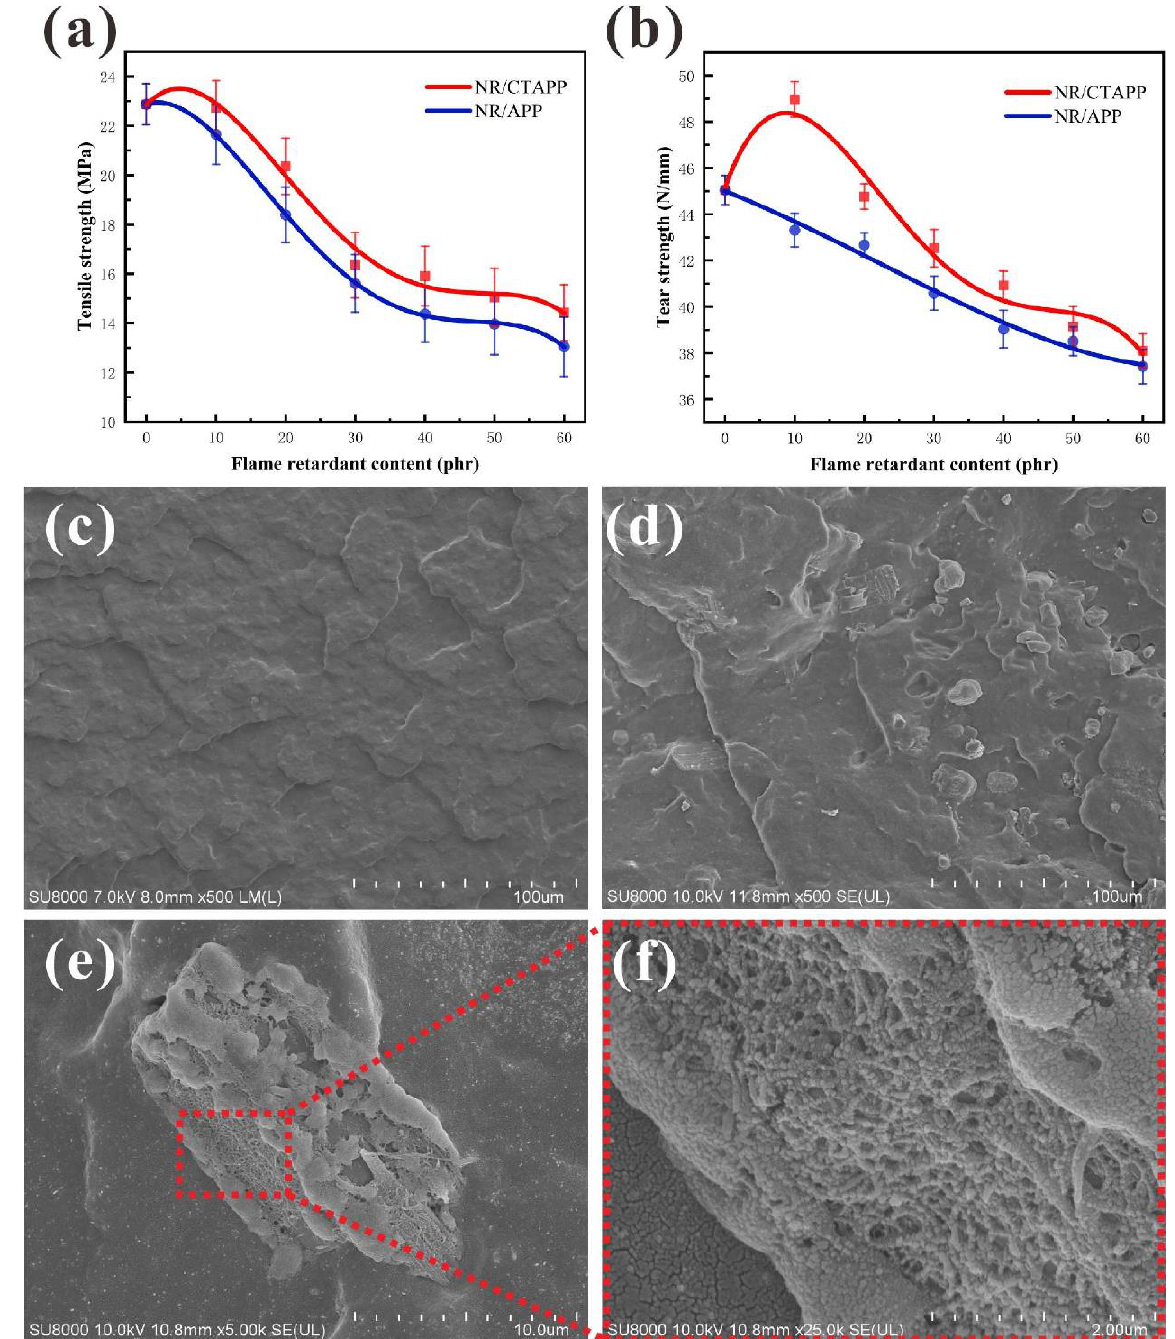
Figure 9. Mechanical properties analysis of composites: ( a ) tensile strength of NR/CTAPP and NR/APP composites; ( b ) tear strength of NR/CTAPP and NR/APP composites; ( c ) low temperature